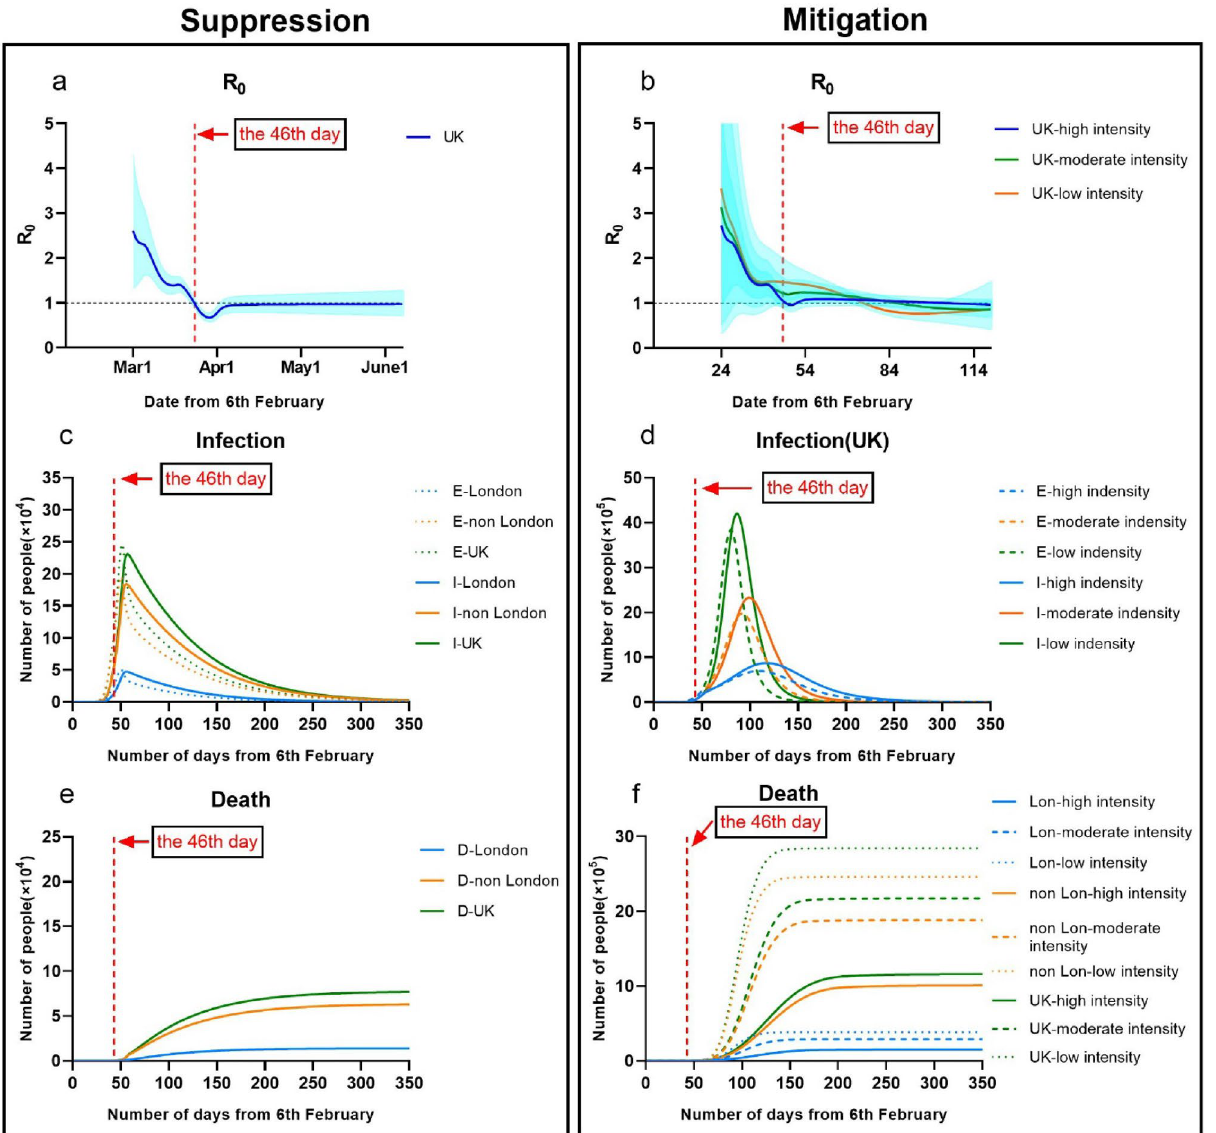
Figure 1. Illustration of controlling COVID-19 outbreaks in London and non-London regions by taking suppression and mitigation with parameters. ( a ) London population: 9.30 million; non-London population: 57.2 million. ( b ) Suppression Intervention (M = 3), Mitigation Intervention: Low (M = 10). Moderate (M = 8). High (M = 6) ( E number of exposed, I number of infections, D number of